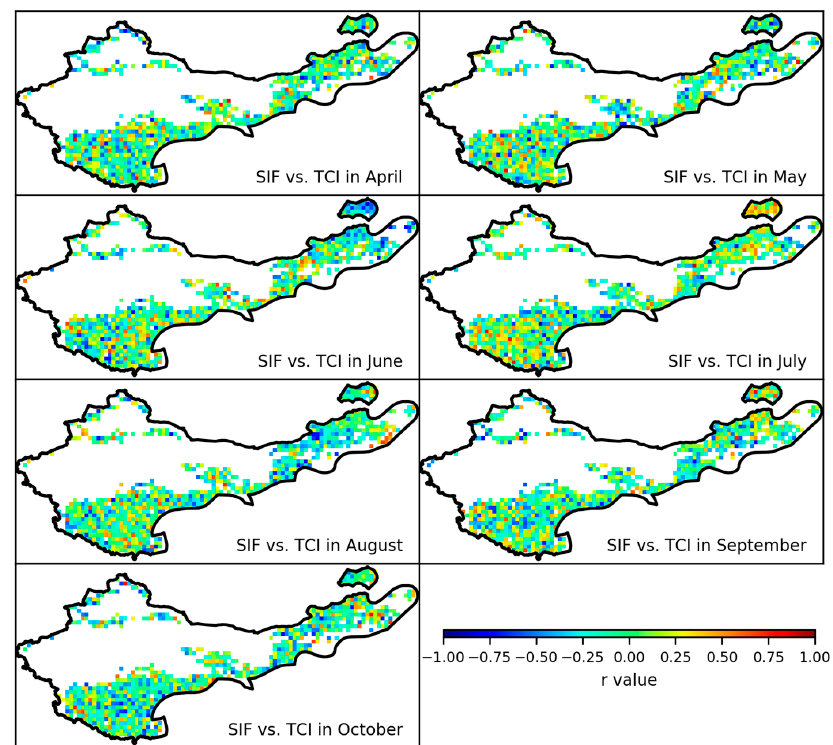
Figure 6. Spatiotemporal distribution of the correlation coefficients between SIF and soil moisture (SM) in each month of growing season. Pixels with white color mean non-grassland or missing data.